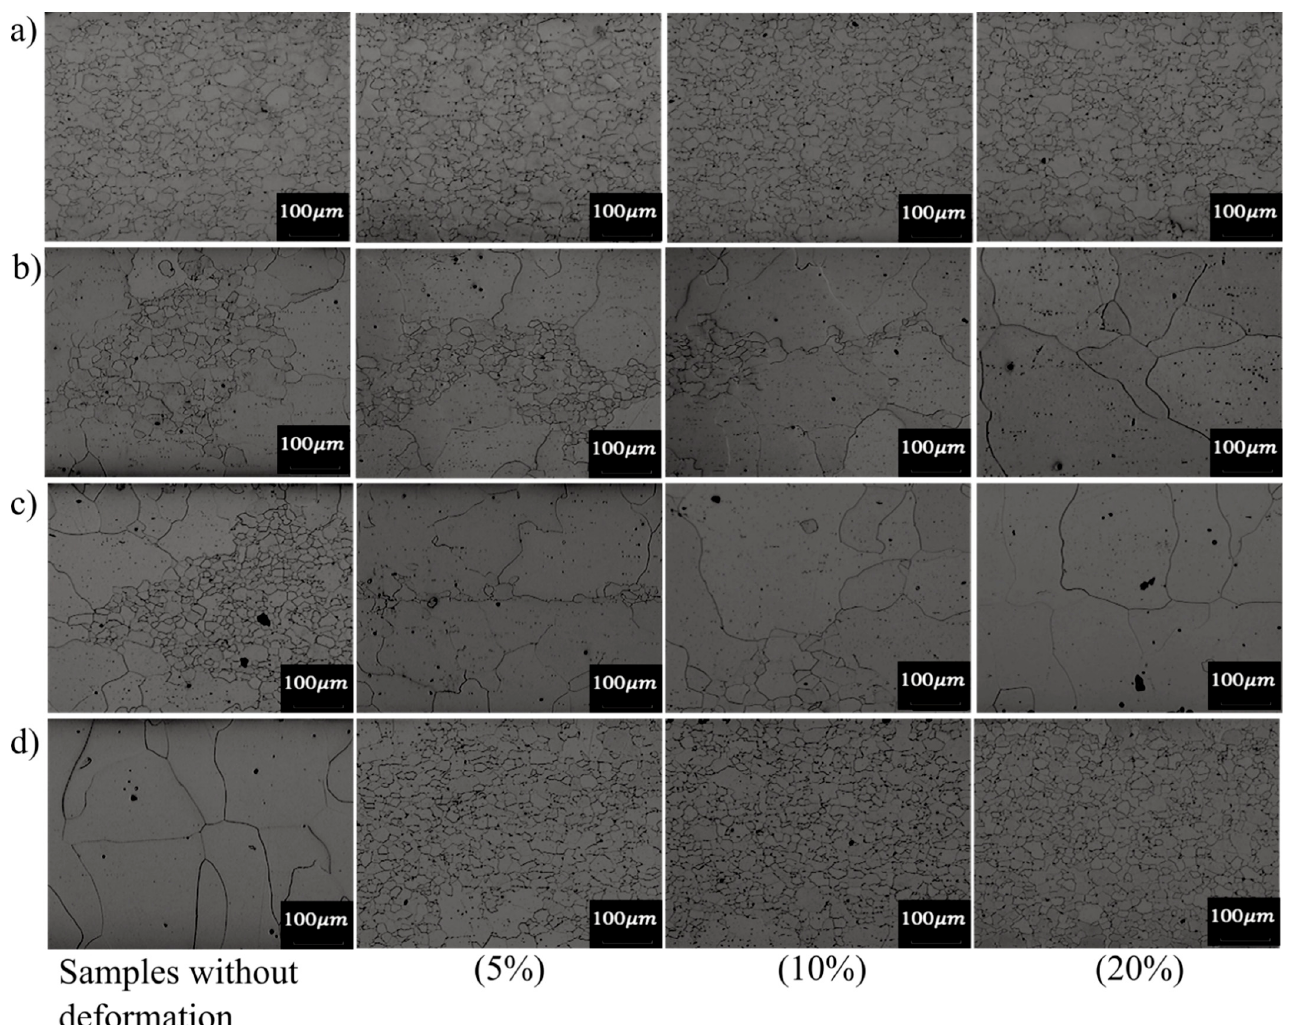
Figure 4. Microstructures of the semi-processed GNO electrical steel annealed at ( a ) 650 °C, ( b ) 750 °C, ( c ) 850 °C, ( d ) 950 °C, in initial condition (without deformation) and with prior deformation.